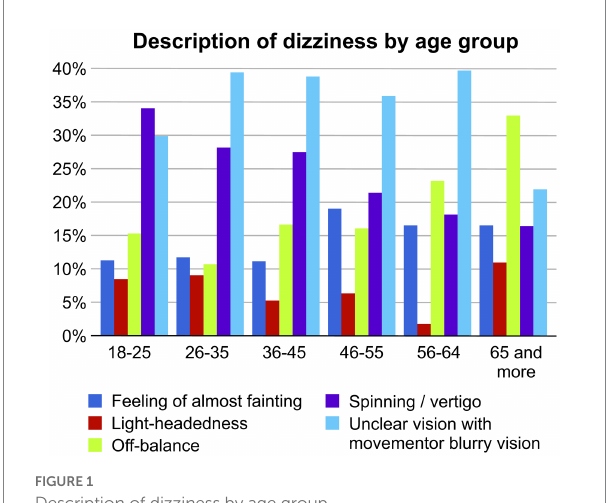
FIGURE 1 Description of dizziness by age group.